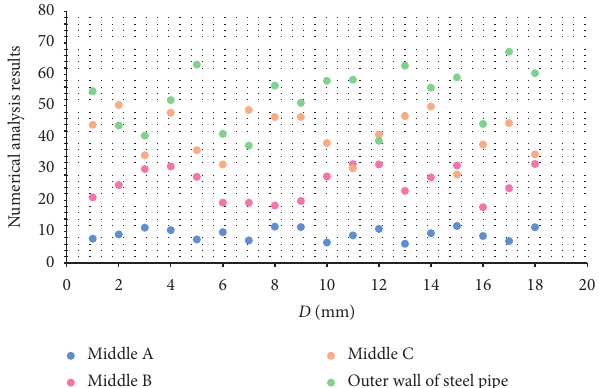
Figure 5: Calculation results of numerical analysis.